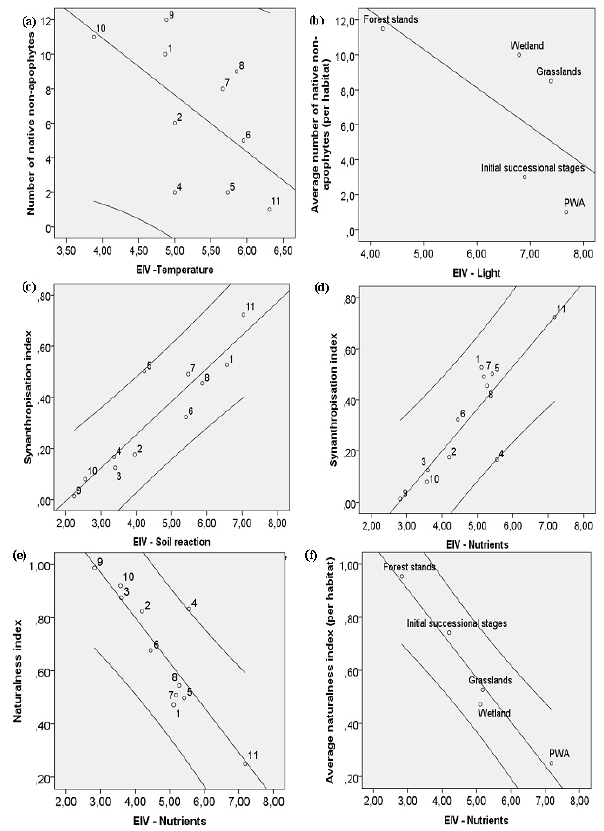
Figure 5. Scatter plots of the selected correlation associations be- tween selected numbers of species, indexes of synanthropisation, naturalness and certain Ellenberg indicator values. Panels (a) , (c) , (d) and (e) illustrate correlations within the relevés framework and panels (b) and (f) illustrate correlations within the habitats frame-